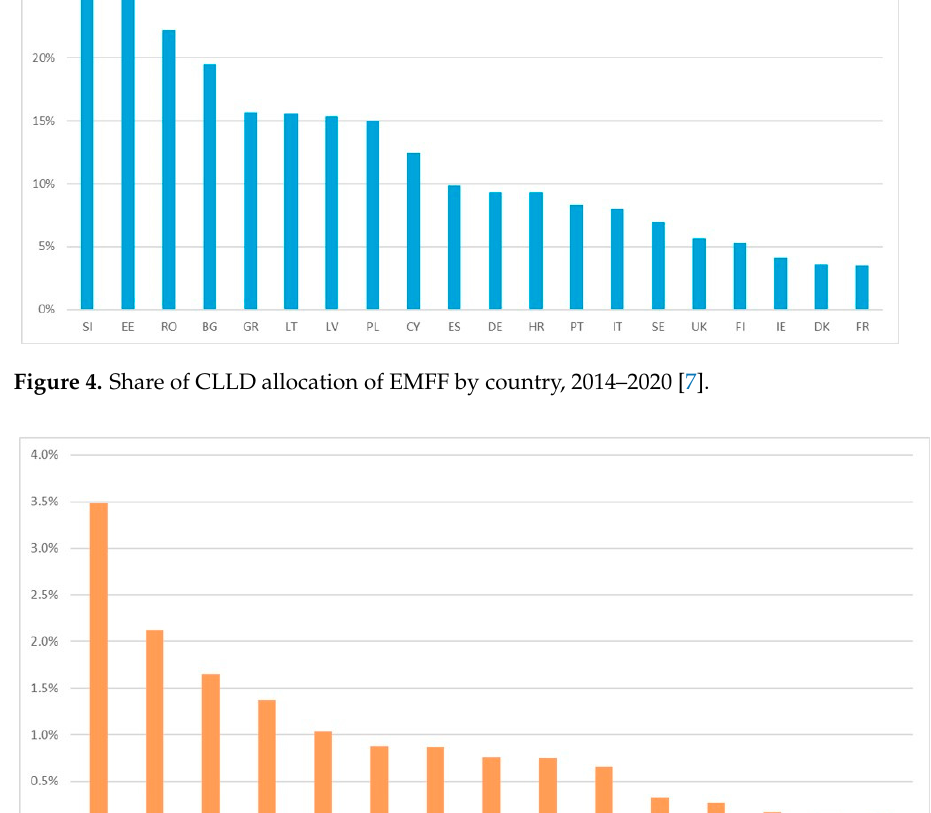
Figure 5. Share of CLLD allocation of ERDF by country, 2014–2020 [7].